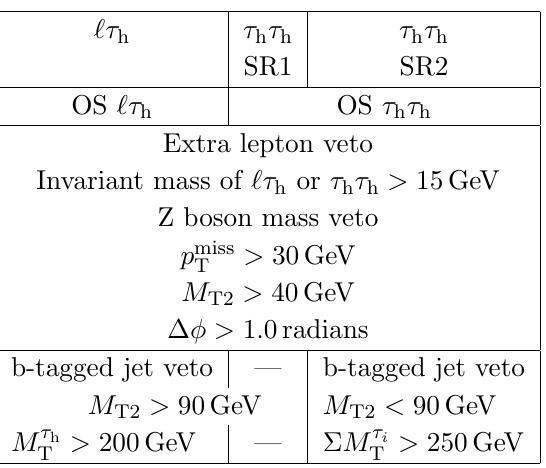
Figure 2 . The M T2 distribution before applying the (cid:12)nal selections on M T2 and M to SM expectation in (left) e (cid:28) h and (right) (cid:22)(cid:28) h channels. The signal distribution is shown for m = 380 GeV ; m = 1 GeV. The last bins include all over(cid:13)ows to higher values of M T2 . Only (cid:6) e (cid:31) 0 1 e (cid:31) 1 the statistical uncertainties are